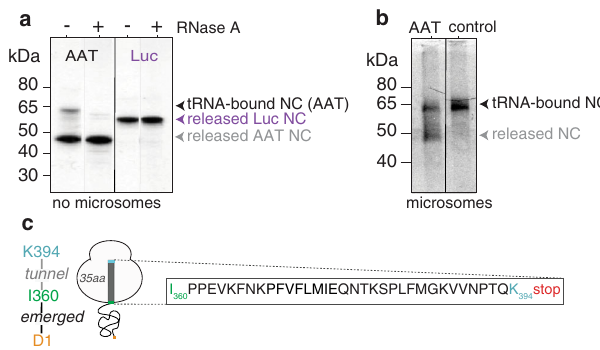
Fig. 2 AAT forms persistent full-length ribosome-nascent chain complexes. a Biosynthesis of AAT and luciferase (Luc) after a 60 min biosynthesis reaction quenched with cycloheximide in the absence of microsomes (both DNA constructs contain stop codons). Highlighted are the full-length, tRNA-bound nascent chains (NC) and full-length, released nascent chains. b Biosynthesis of AAT in the presence of microsomes, alongside a control (AAT DNA construct with no stop codon to force production of RNCs), highlighting that both full-length tRNA-bound nascent chains (NC) and released nascent chains can be formed in the endoplasmic reticulum. Source data are provided as a Source Data fi le. c Schematic of a full-length AAT RNC showing the sequence expected within the tunnel and beyond the ribosome. Note that a and b show 35 S methionine detection via partially-denaturing PAGE (see “ Methods ” folding fate. In this work, we thus show a basis of a folding- misfolding branchpoint that is initiated on the ribosome, and is a fi nding which has implications for targeting conformational diseases.